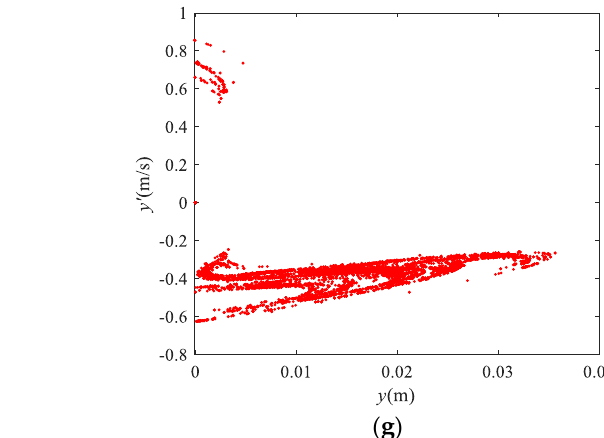
Figure 5. Nonlinear behavior of a particle at different frequencies: ( a ) Bifurcation diagram of different frequencies; ( b ) Phase diagram at f = 6 Hz; ( c ) Poincaré map at f = 6 Hz; ( d ) Phase diagram at f = 6.5 Hz; ( e ) Poincaré map at f = 6.5 Hz; ( f ) Phase diagram at f = 8 Hz; ( g ) Poincaré map at f = 8 Hz.